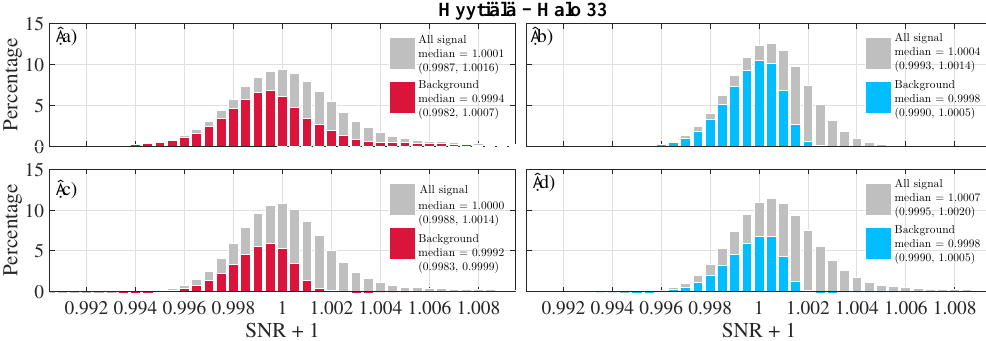
Figure 9. Histograms of (a, c grey) uncorrected, and ( b, d grey) corrected SNR; ( a, c red) uncorrected and ( b, d blue) corrected background for the upper 20% of range bins ( a, b ) and the lowest 20% of the range bins ( c, d ). All data were measured with a Halo Doppler lidar (instrument ID: 33) between 21 May 2014 and 31 December 2014 at Hyytiälä, Finland.